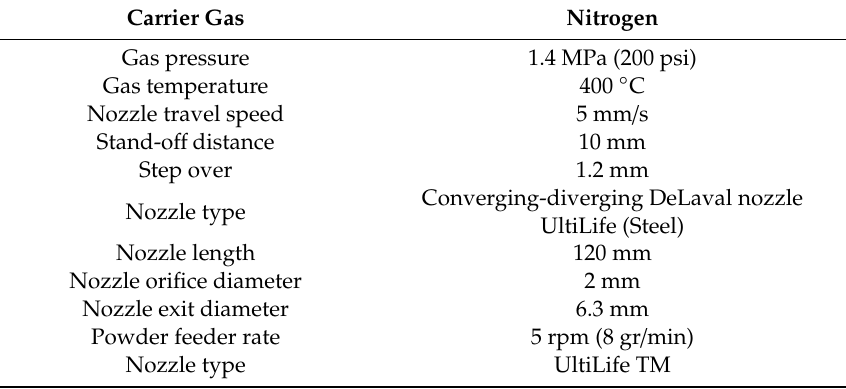
Table 1. Cold spray deposition parameters used in this